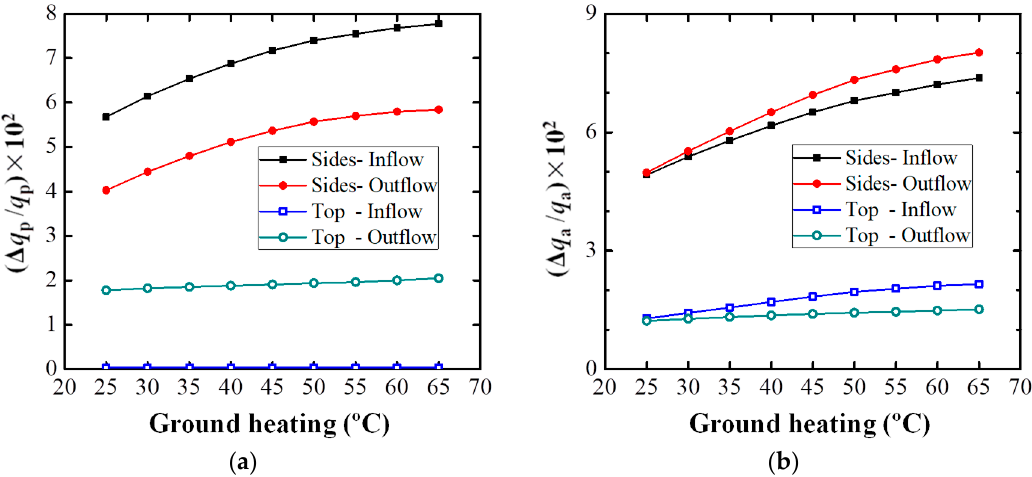
Figure 17. Changes in total pollutant flow rates and air flow rates with ground heating (TSC): ( a ) total pollutant flow rates; ( b ) air flow rates.